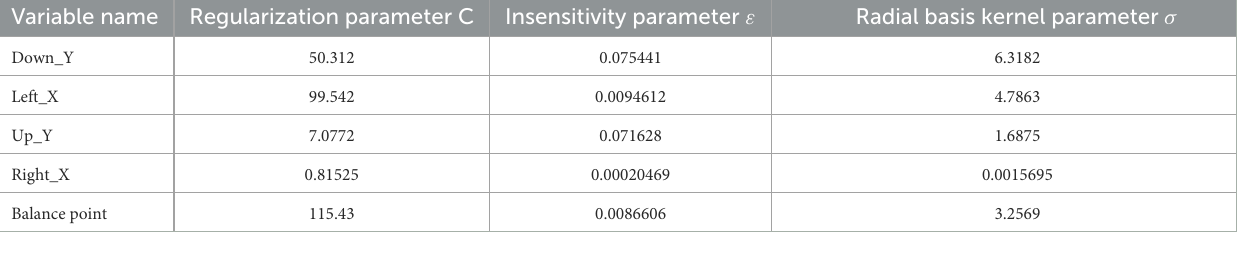
TABLE 4 MSE values for test